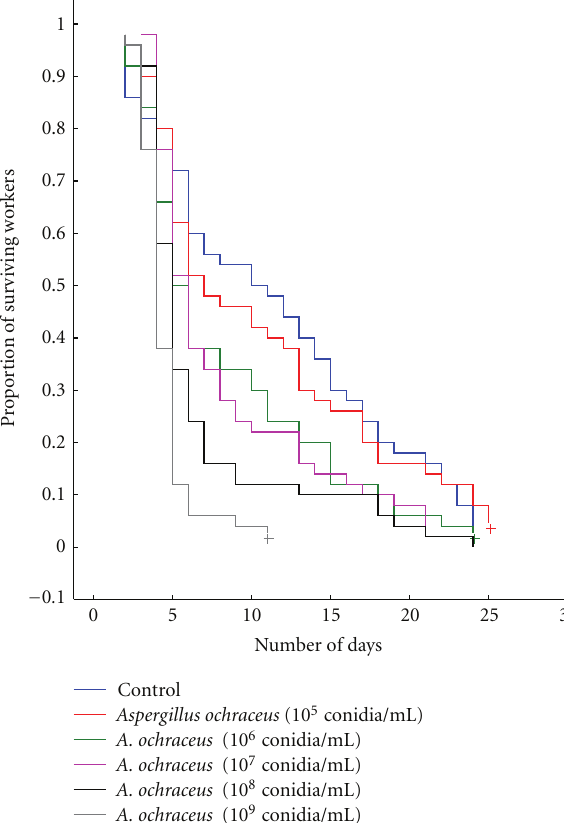
Figure 2: Cumulative time-related survival proportion (Kaplan- Meier curves) of the Atta bisphaerica worker ants after being treated with di ff erent suspension concentrations of the Aspergillus ochraceus fungus